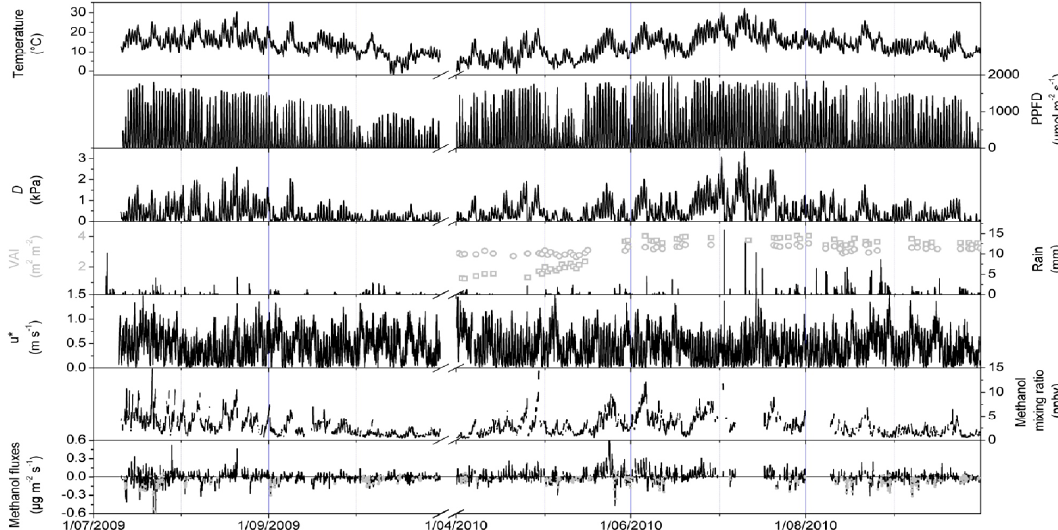
Fig. 3. Temporal evolution of meteorological variables, methanol mixing ratio and methanol flux between 10 July and 31 October 2009 and between 1 April and 30 September 2010: air temperature ( T a ), PPFD, vapour pressure deficit ( D ), precipitation, vegetation area index (VAI) of beeches ( (cid:3) ) and Douglas ( (cid:13) ) , friction velocity ( u ∗ ), ambient methanol mixing ratio and methanol fluxes (the rain events are identified with grey points).